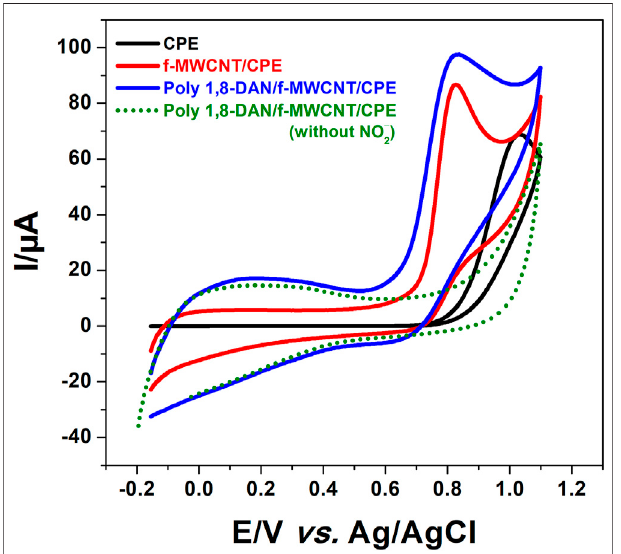
FIGURE 6 | CV of CPE (balck line), f-MWCNT/CPE (red line), and poly 1,8-DAN/f-MWCNT/CPEin0.1 MPBScontaining0.1 MKCl(green dots)and 1 mM NO 2 − (blue line) at pH 7, 2 and a scanning speed of 50 mV/s.